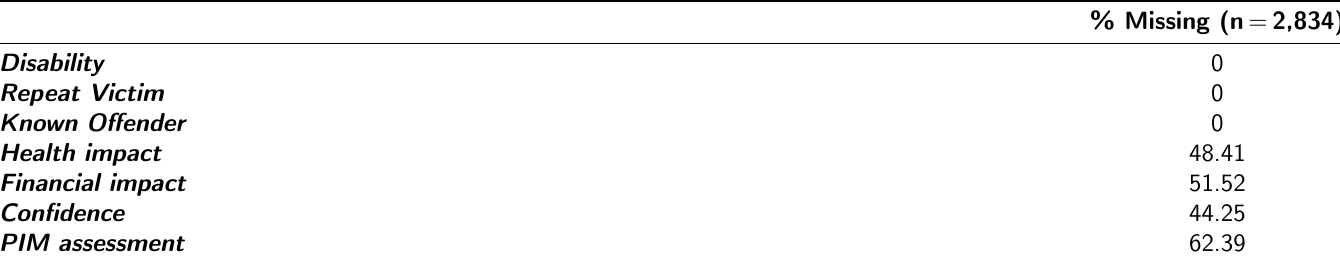
Table 5: Percentage of missing values for victim impact assessment variable in Study 2 (individual reports